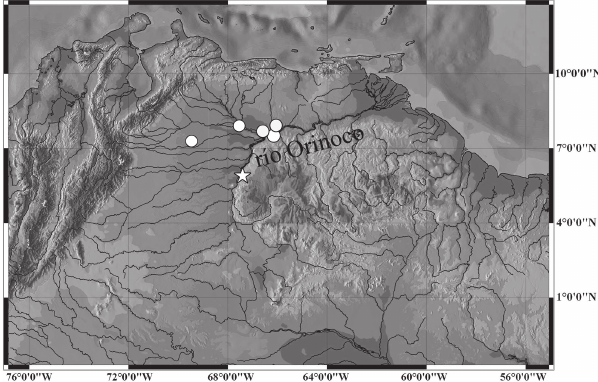
Fig. 7. Map of northern South America, illustrating the geographic distribution of Eigenmannia sayona . Star indicates type locality. Some points represent more than one locality.